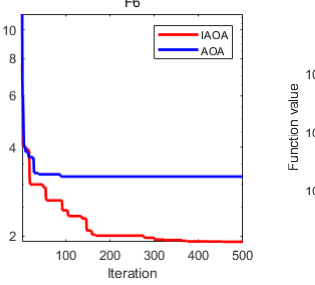
the convergence curves of the AOA and IAOA, respectively; the horizontal axis denotes the number